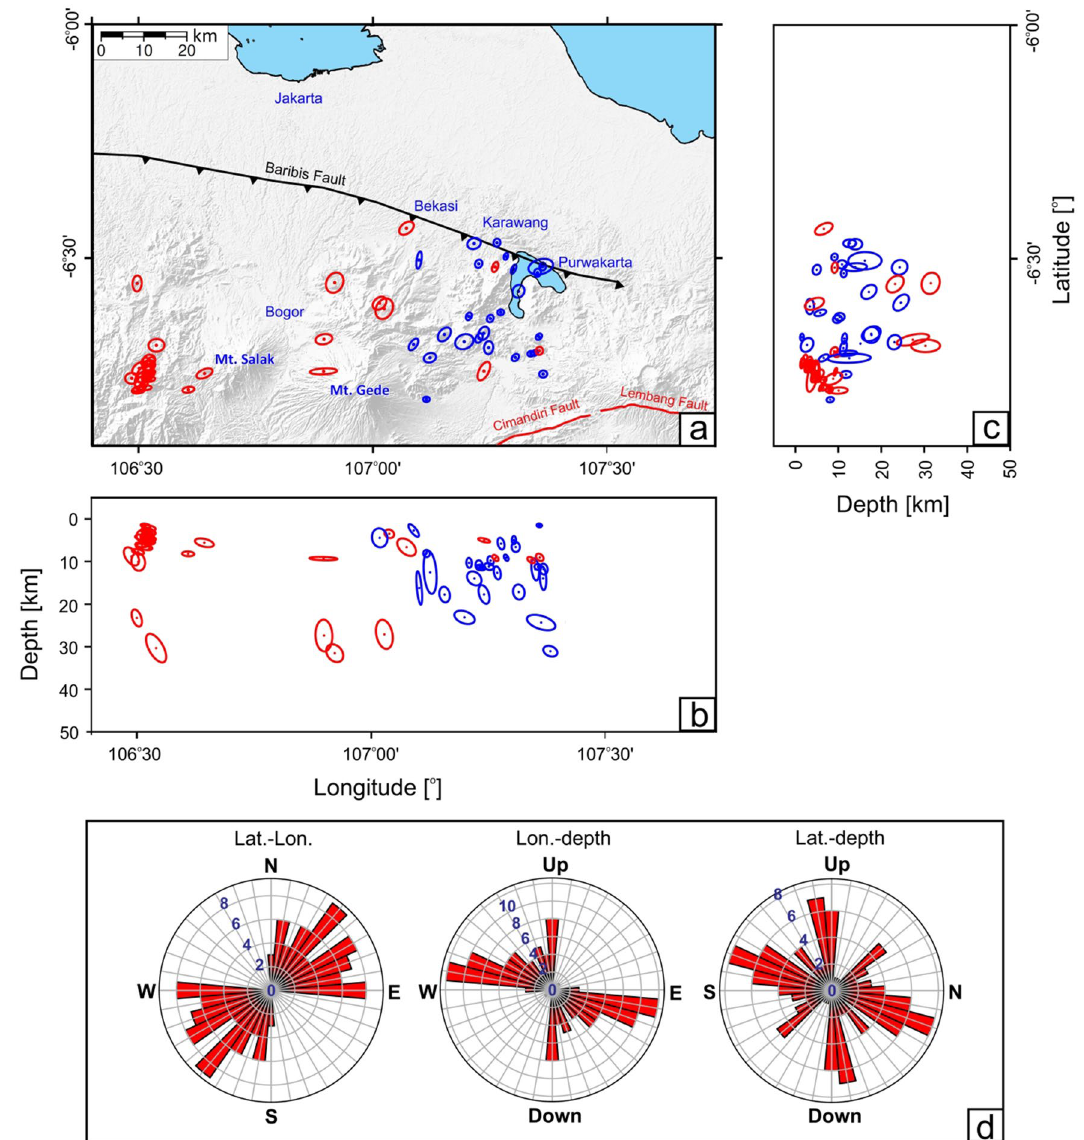
Figure 2. Bootstrap uncertainty analysis results. Map of the relative location errors for the relocated events shown in Fig. 1b. ( a ) map view. ( b ) and ( c ) vertical cross sections in longitude and latitude, respectively. They are plotted on a 1 to 1 horizontal to vertical scale. Location error estimates are represented by 95% confidence ellipsoids obtained from a bootstrap analysis of the final double-difference vector. Red and blue dots depict hypocenters from Damanik et al. 18 and this study, respectively. ( d ) Rose diagrams of the event uncertainties, as defined by the major axis of the 95% confidence ellipsoids. From left to right: map view, longitude vs. depth, and latitude vs. depth. Numbers in the diagram indicate the number of events within each bin of 10 degrees. The Generic Mapping Tools (GMT) version 6.0 59 (https:// www. gener ic- mappi ng- tools. org/) was used to make